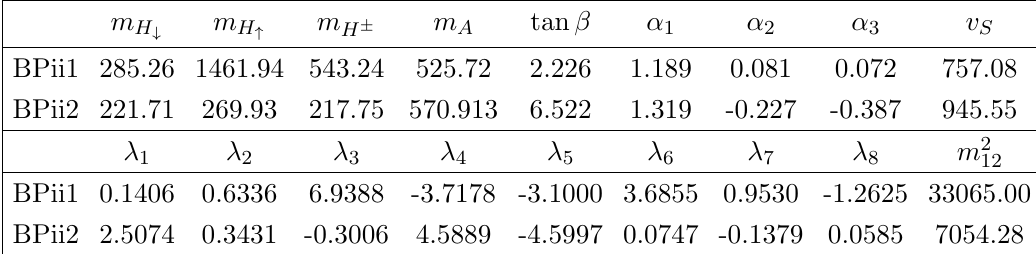
Table 8 . N2HDM T1 benchmark points BPii1 and BPii2 with heavy mass hierarchy. The masses and the singlet VEV v s are given in